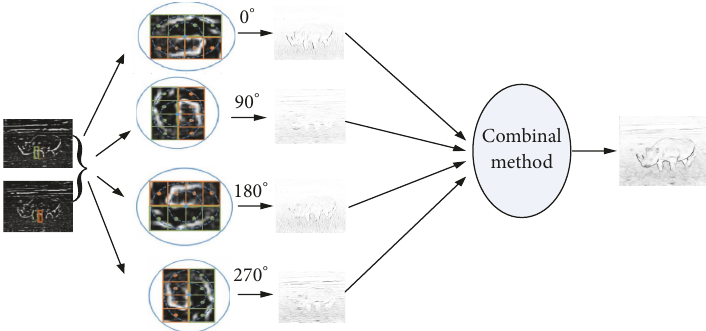
Figure 3: The process of detection and illustration of constructed